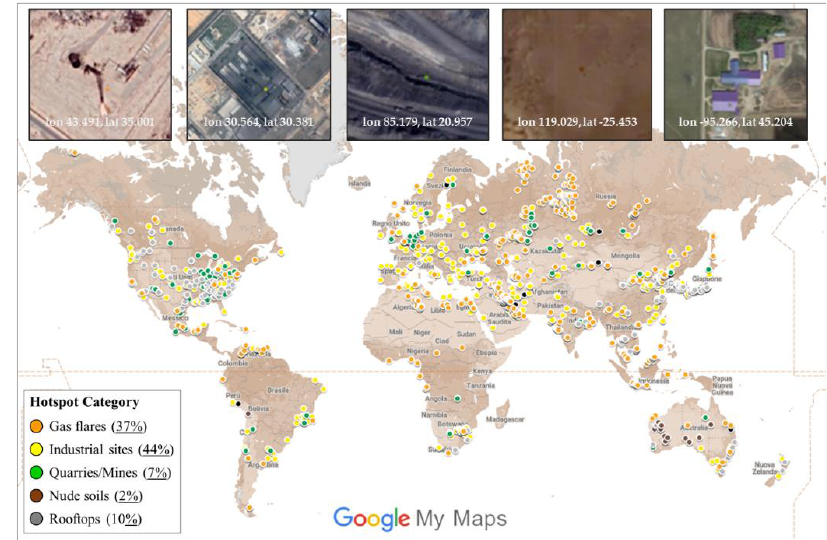
Figure 1. Candidate GF sites identified by setting OF ≥ 10% (see text) .